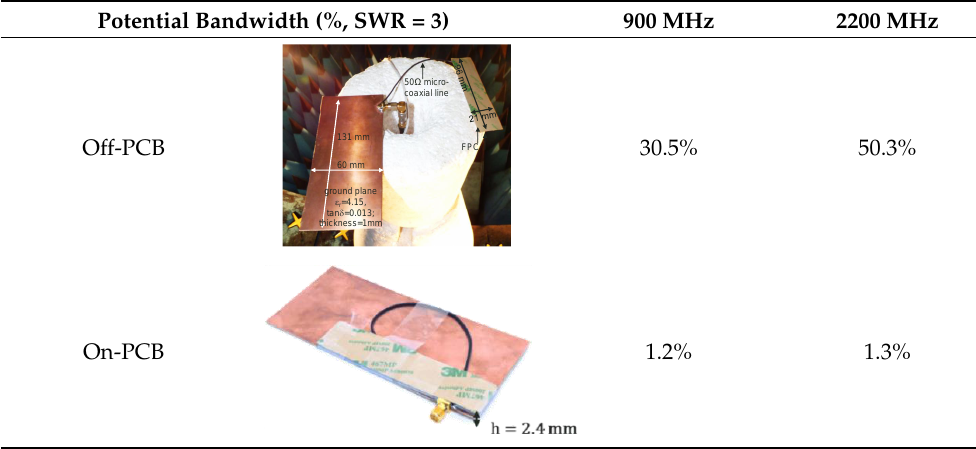
14 Figure 15. Measured S 11 for the 12 mm × 3 mm × 2.4 mm (h) antenna booster and FPC at three dif- ferent heights over the ground plane (2.4 mm, which is the same height as the antenna booster, 10 mm and 20 mm). PCB is 131 mm × 60 mm. The question is whether the performance can be again recovered by using a matching network. The matter is addressed by computing the potential bandwidth, which calcu- lates the bandwidth an antenna system can reach with input impedance data. Potential bandwidth has been computed with Optenni-Lab [15]. The issue is that the potential band- width of the FPC on-PCB decreases drastically, as expected from the basic antenna theory of antennas electrically close to conductive planes. The potential bandwidth is compared for the off-PCB and on-PCB for two frequencies (Table 8). As shown, the potential band-